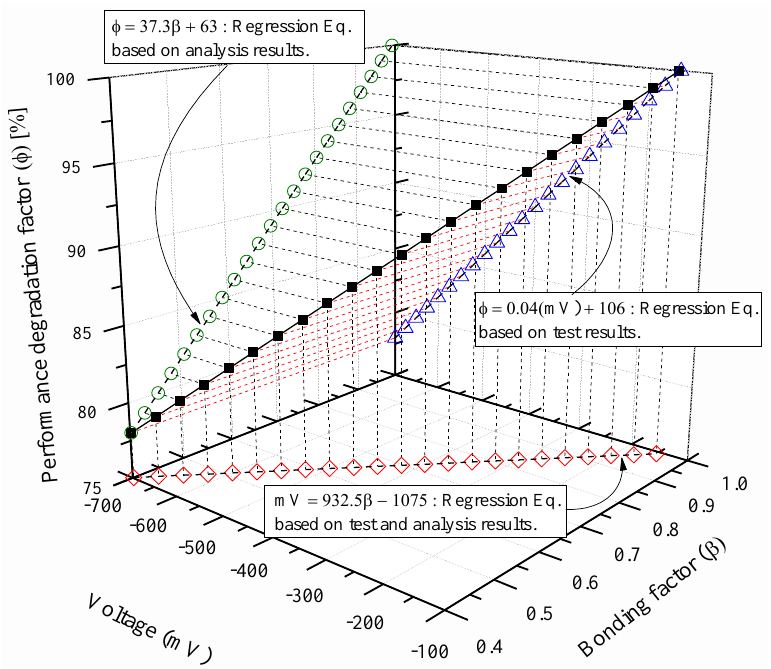
Figure 22. 3D plot of performance reduction factor ( ϕ ), bonding factor ( β ), and average potential difference in terms of voltage (mV) of corroded shear beam.